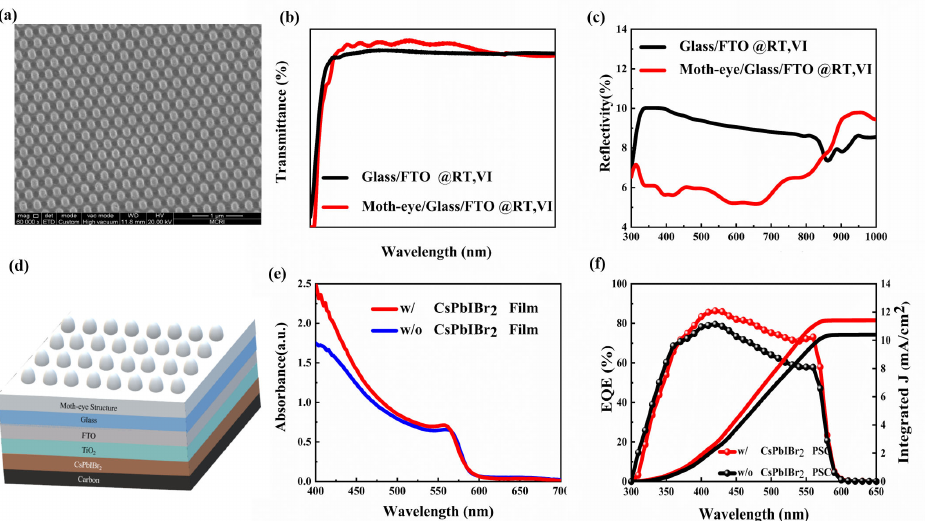
Figure 1. ( a ) SEM image of moth-eye nanostructures; ( b ) Transmission and ( c ) reflection spectrum of moth-eye/glass and glass under RT and VI conditions; ( d ) Schematic image of CsPbIBr 2 PSCs with moth-eye nanostructures; ( e ) Absorption spectra of CsPbIBr 2 film and ( f ) EQE curves and corresponding J inte of CsPbIBr 2 PSCs with and without moth-eye nanostructure.